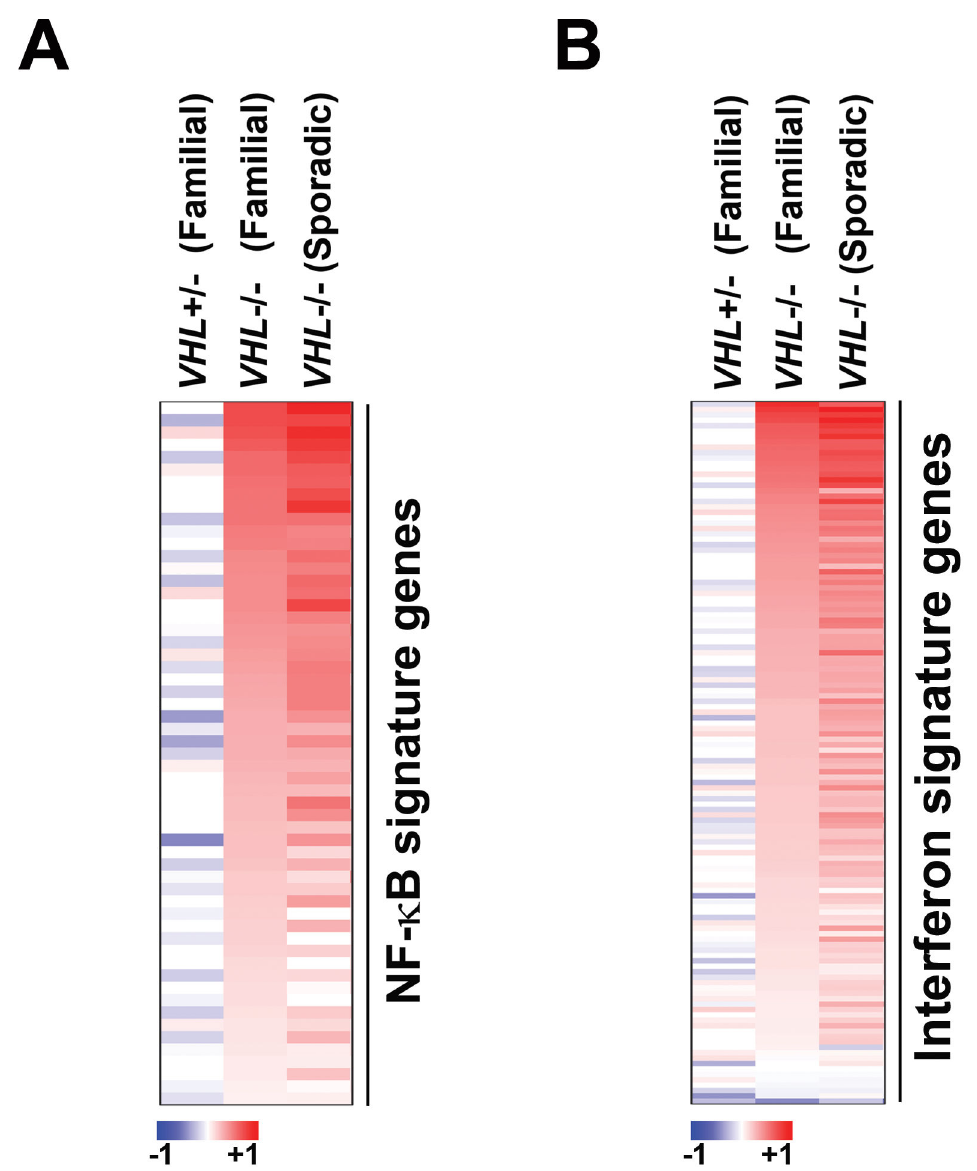
Figure 5. VHL mutational status correlates with expression of NF-κB and IFN signatures. Heatmaps showing fold-changes in expression levels of NF-κB signature genes (a) or IFN signature genes (b) between VHL+/- samples from cases of familial VHL disease compared to VHL +/+ normal renal epithelium (column 1) ; VHL-/- cases of familial ccRCC compared to normal renal tissue (column 2) ; or VHL-/- cases of sporadic ccRCC compared to normal renal tissue (column 3). Heat bar = fold-change (log